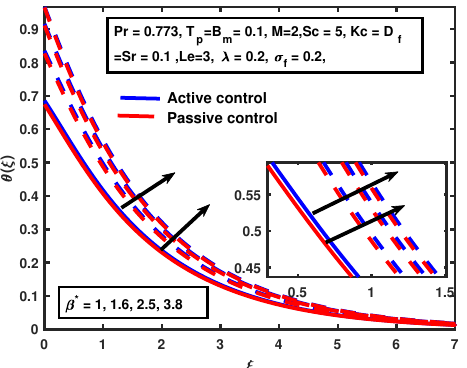
Figure 8. The impact of θ ( ξ ) on Biot number β ∗ .